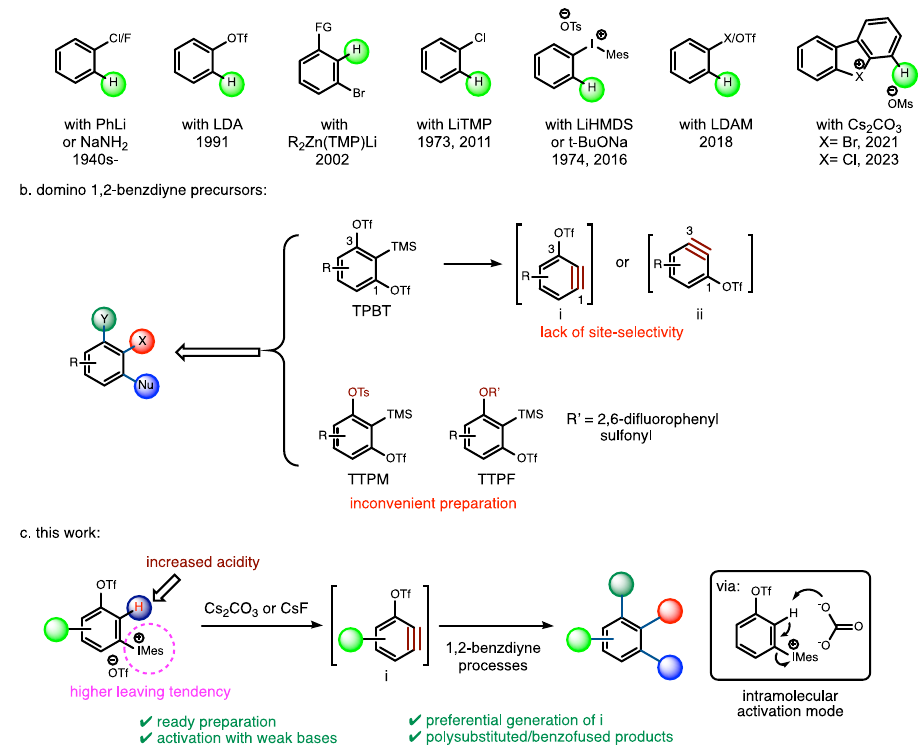
Fig. 1 | Background and our work. a Timeline of ortho -deprotonative elimination protocols. b Problems associated with the application of previous domino 1,2- benzdiyne precursors. TPBT: 2-(trimethylsilyl) − 1,3-phenylene